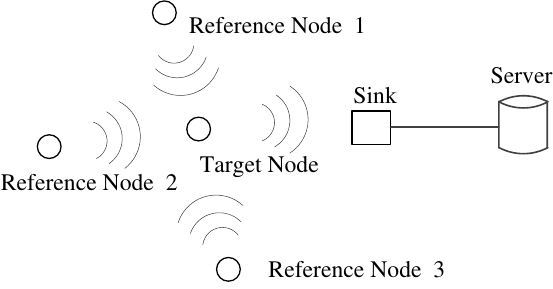
Figure 1. The network hardware infrastructure and logical communication links of